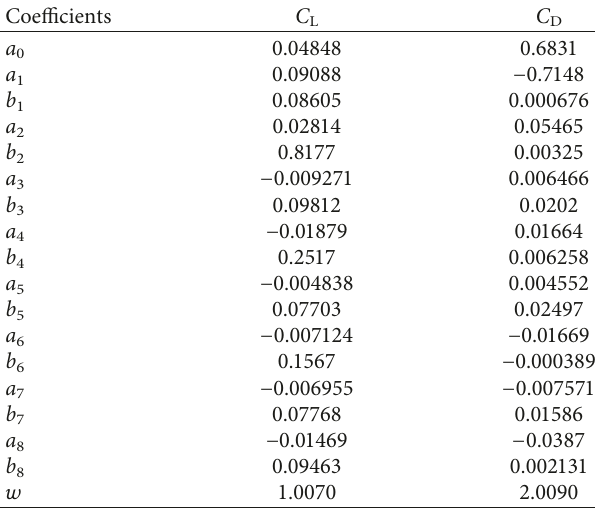
Figure 1: Coordinate system of blade sections. (a) Without pretwist. (b) Pretwisted Table 1: The coefficient parameters in the Fourier series model.